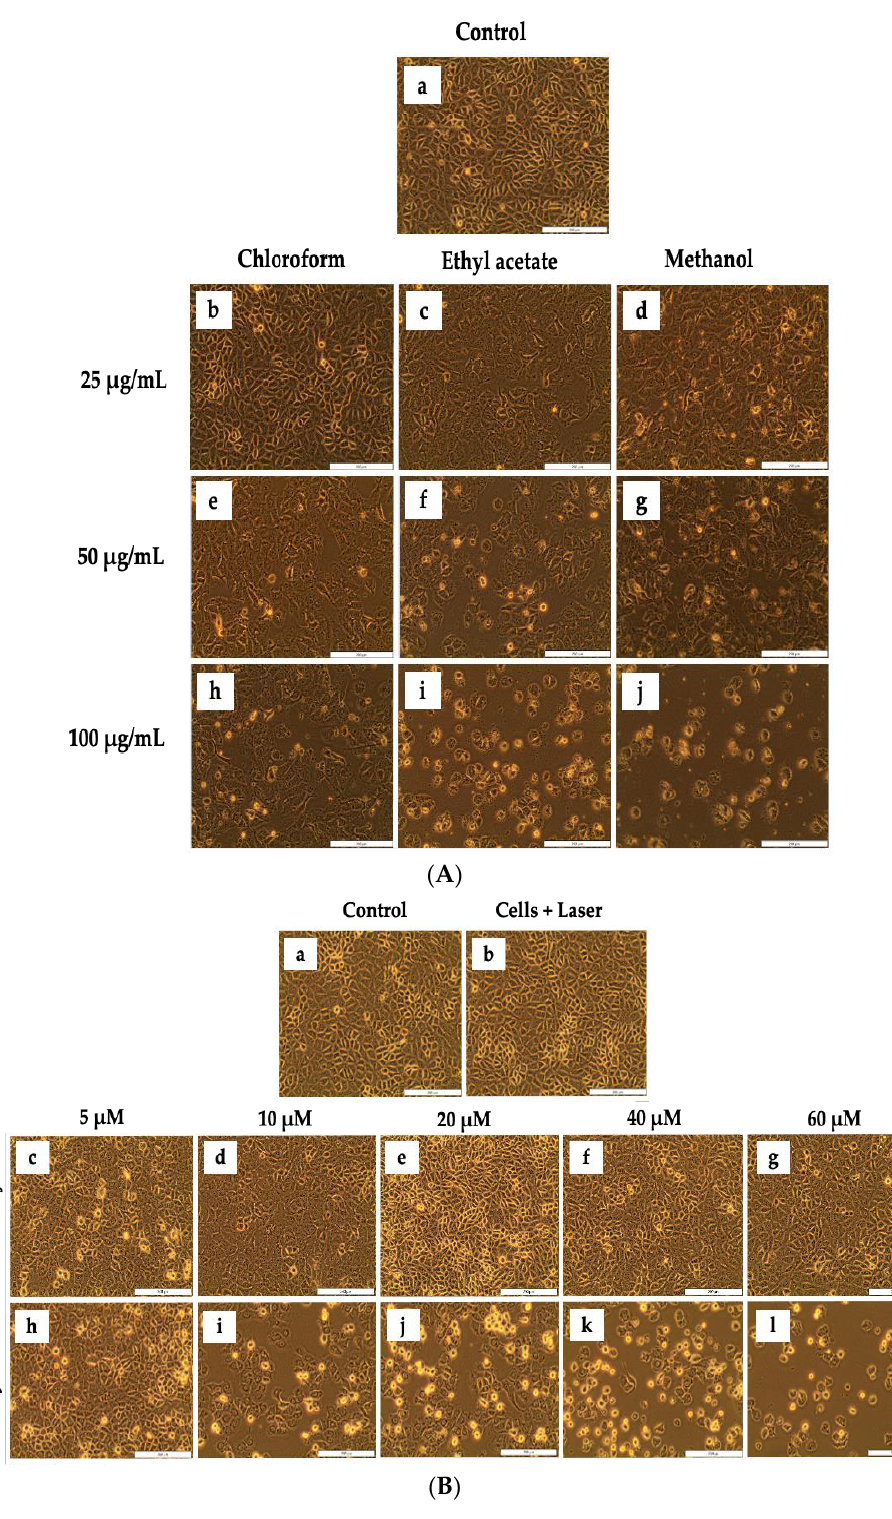
Figure 3. Morphological analysis of A549 cells post-treatment with D.A (Chl, EtOAc, and MeOH) root extracts ( A ) and ZnPcS 4 dark toxicity and 680 nm laser irradiation ( B ). No morphological changes were displayed by A549 treated cells ( A ( b )) and ( B ( b – g )) when compared to the control cells ( A , B ( a )). Morphological changes were displayed by A549 cells ( A ( c – j )) and ( B ( h – l )). (200 × magnification and scale bar: 200 μm).